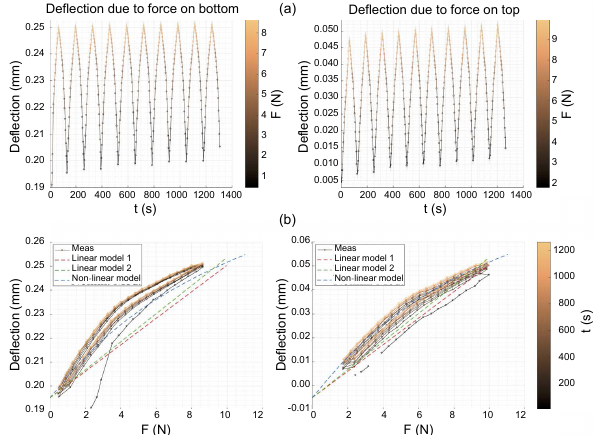
Deflection due to force on bottom